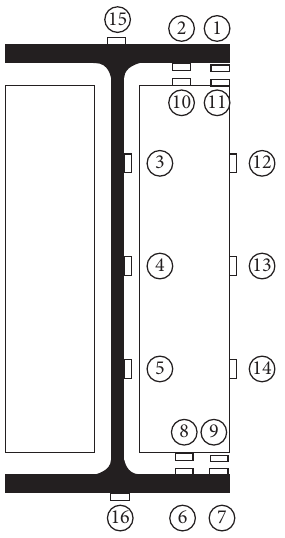
Figure 5: Midspan strain gauge layout.